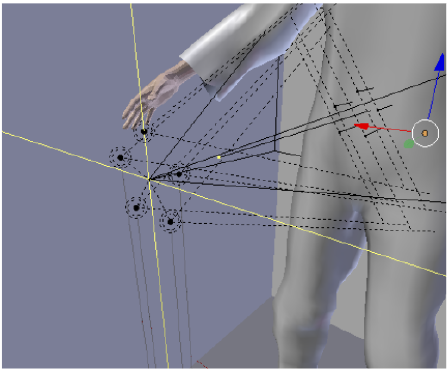
Figure 5. Possible points of illumination can be chosen within the simulated